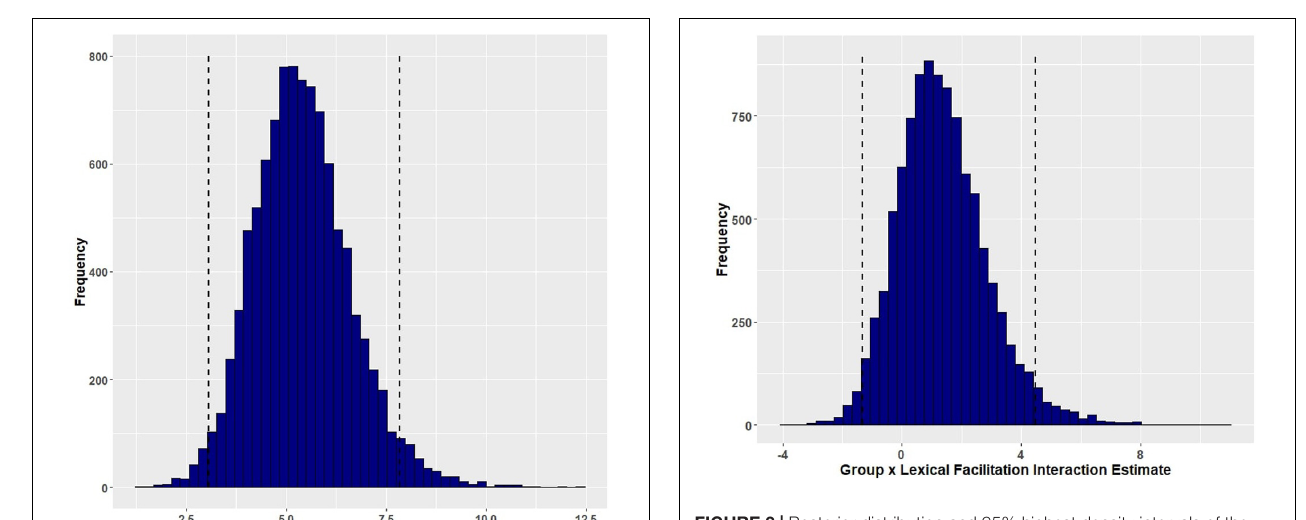
FIGURE 3 | Posterior distribution and 95% highest density intervals of the interaction effect of group and lexical co-occurrence facilitation from Model 1 (accuracy for participants with aphasia and healthy controls). Dashed lines mark the 95% highest density intervals (HDIs) for the posterior distribution.